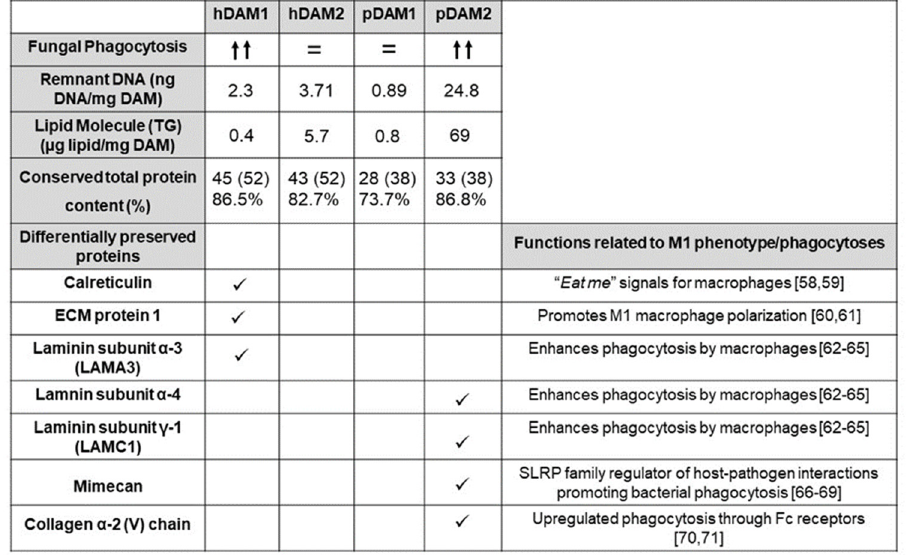
Figure 7. Fungal phagocytosis by macrophages exposed to hDAM1, hDAM2, pDAM1, and pDAM2, related to the content of DNA, lipids, and proteins of these matrices and to their differentially preserved proteins.